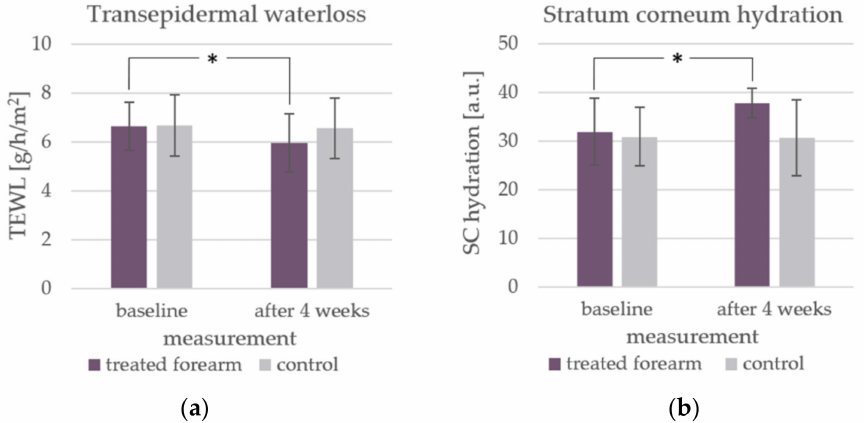
Figure 5. Mean values ( n = 12) of ( a ) transepidermal water loss and ( b ) stratum corneum hydration on forearms as a function of measurement time points (baseline and after 4 weeks) with error bars indicating standard deviation and * symbols indicating statistically significant results ( p <